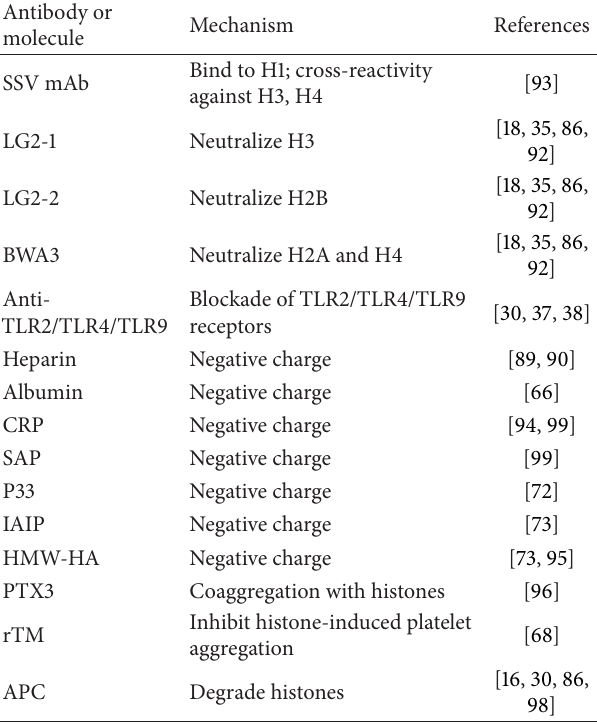
Table 2: Current evidence of targeting extracellular histones for